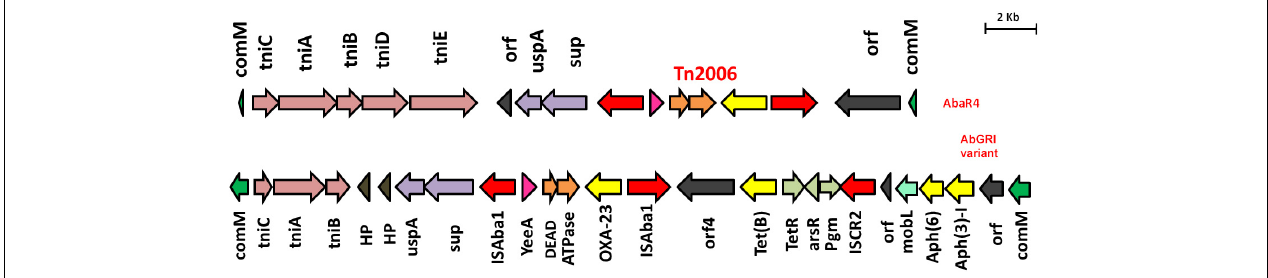
FIGURE 3 | Structures of AbaR4 and variants of AbGRI1 identified in this study. The top figure depicts the typical AbaR4 island, while the bottom figure indicates the AbGRI1 variant due to additional mobL (light green arrow) and arsenic resistance gene, arsR (light gray arrow). The yellow arrow indicates antimicrobial resistance genes, and the red arrow depicts insertion